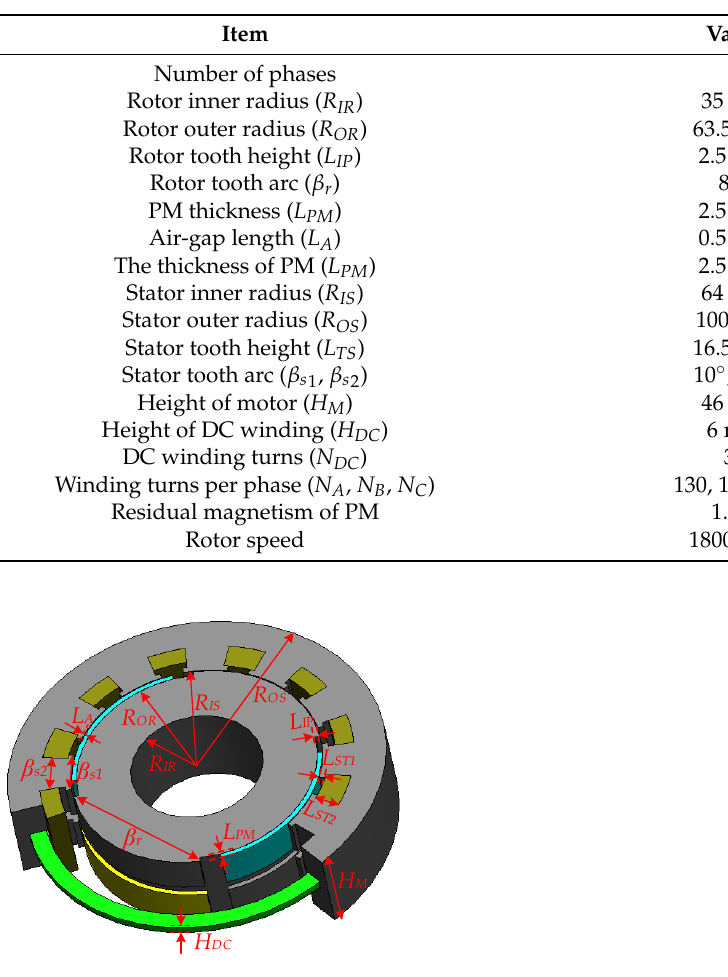
Figure 8. System parameters.